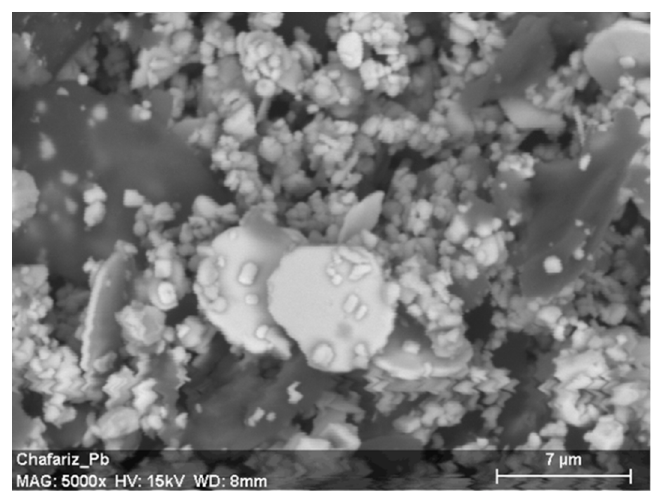
Figure 12. SEM image zoom of the staining area.